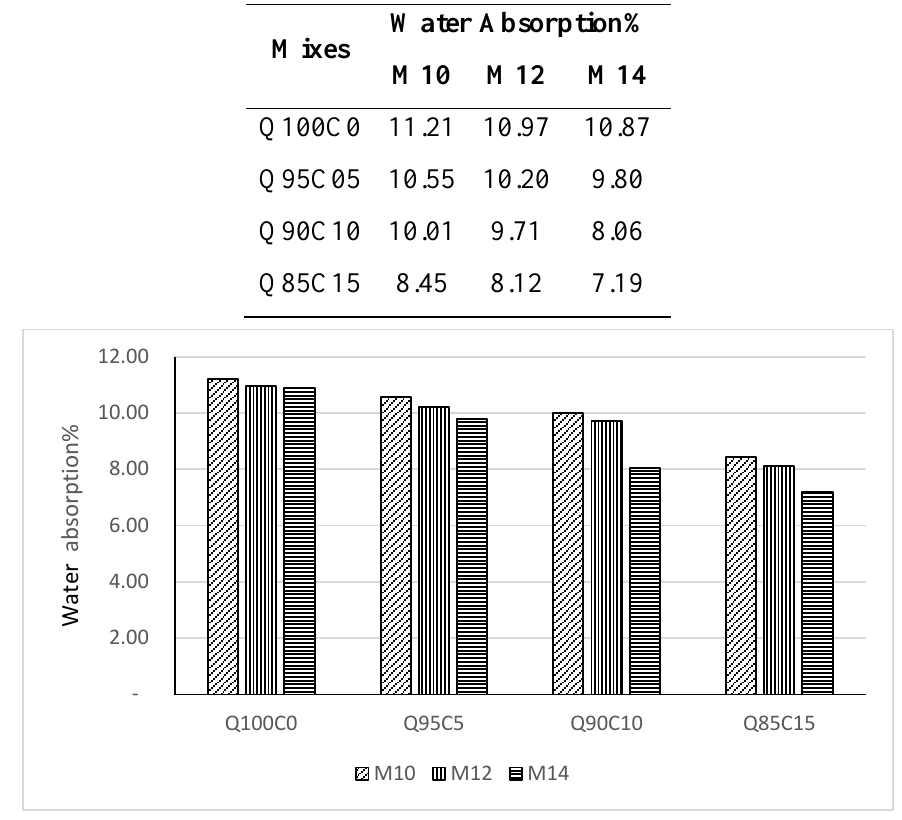
Fig. 7. Effect of OPC replacement and NaOH concentration variation on water absorption of quartz stone powder- based